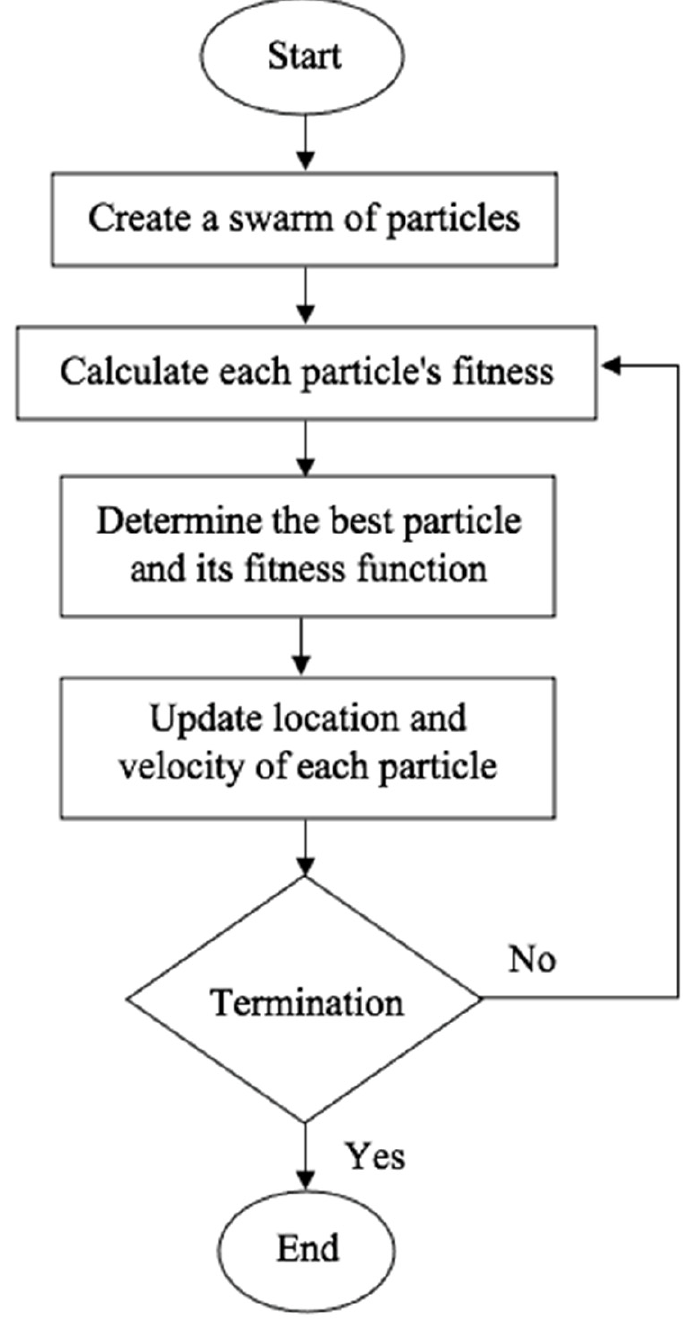
Figure 2. Flowchart of PSO algorithm.